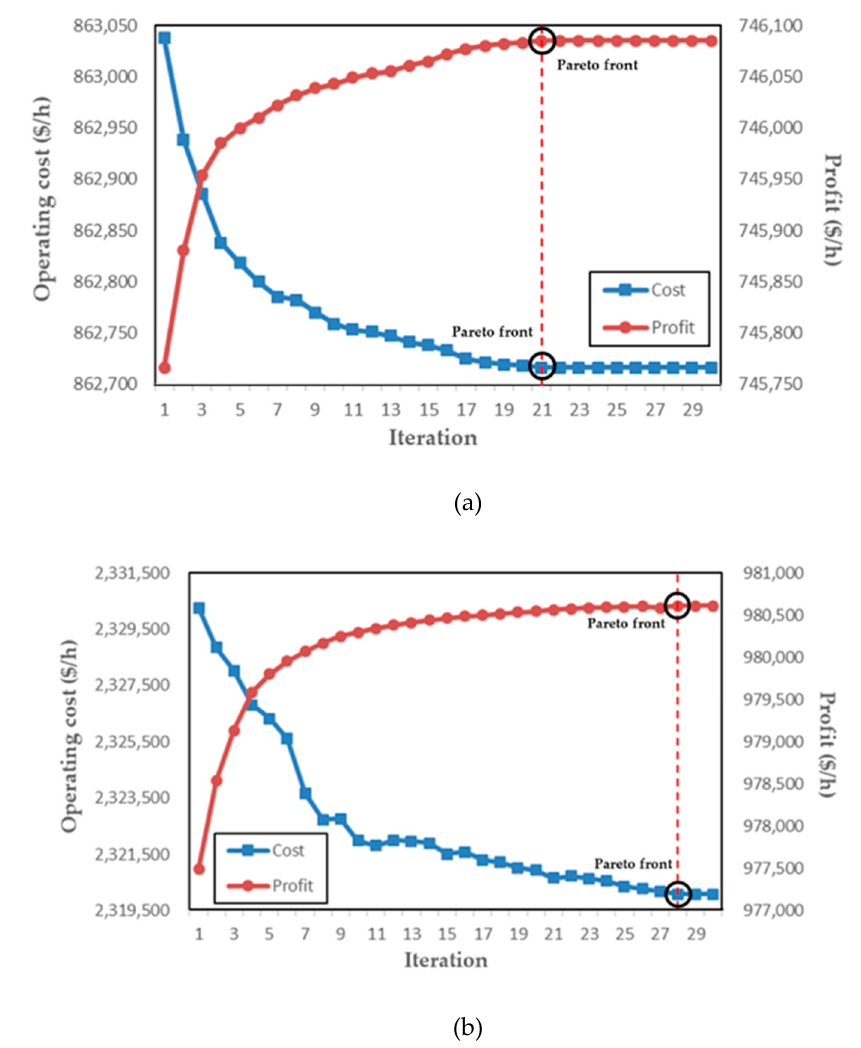
Figure 13. Optimization process for obtained Pareto-front via MNSGA-II: (a) IEEE test system, (b) Figure13. Optimization process for obtained Pareto-front via MNSGA-II: ( a ) IEEE testsystem, ( b ) Actual Actual power system. power